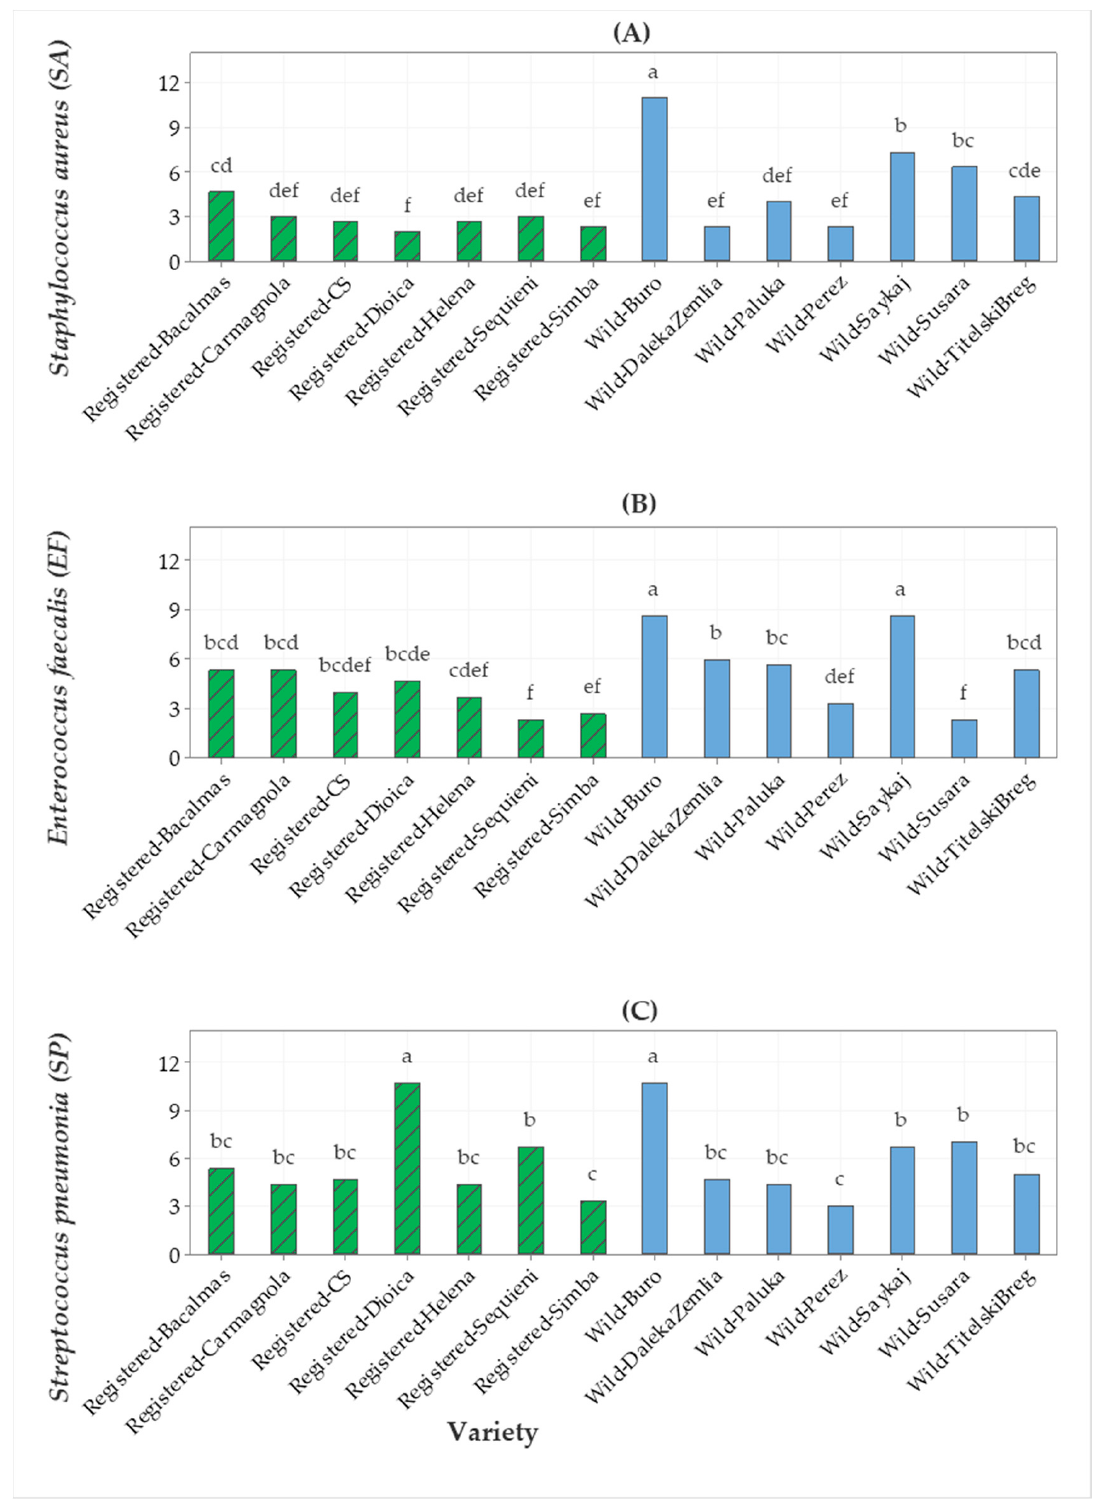
Figure 1. Bar graph of ( A ) Staphylococcus subsp. aureus (SA), ( B ) Enterococcus faecalis (EF), and ( C ) Streptococcus pneumoniae (SP) (gentamycin) antimicrobial activities (inhibition zone in mm) from seven registered cultivars and seven wild accessions. The means represented by the bars sharing the same letter are not significantly different.